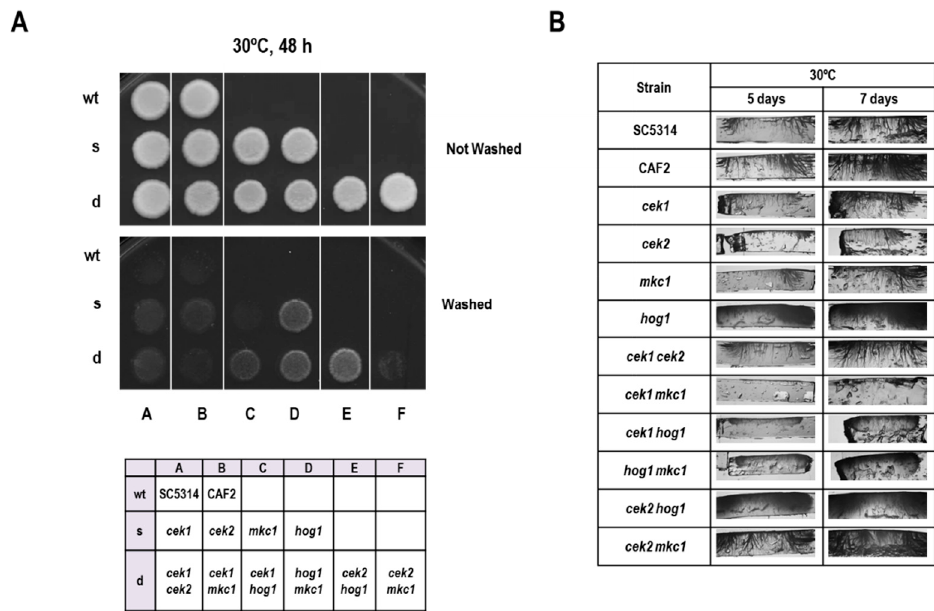
Figure 3. Analysis of invasion of solid media. ( A ) 10 6 cells from overnight grown cultures were spotted on YPD agar plates and incubated for 48 h at 30 ◦ C. The plates were gently washed to allow the analysis of colonies’ invasion (lower panel). A panel showing the position of strains is shown below. ( B ) 10 6 cells from overnight grown cultures were spotted on YPD agar plates and incubated for 5 or 7 days at 30 ◦ C. The plates were gently washed and transversal cuts made for the observation of the invading filaments.